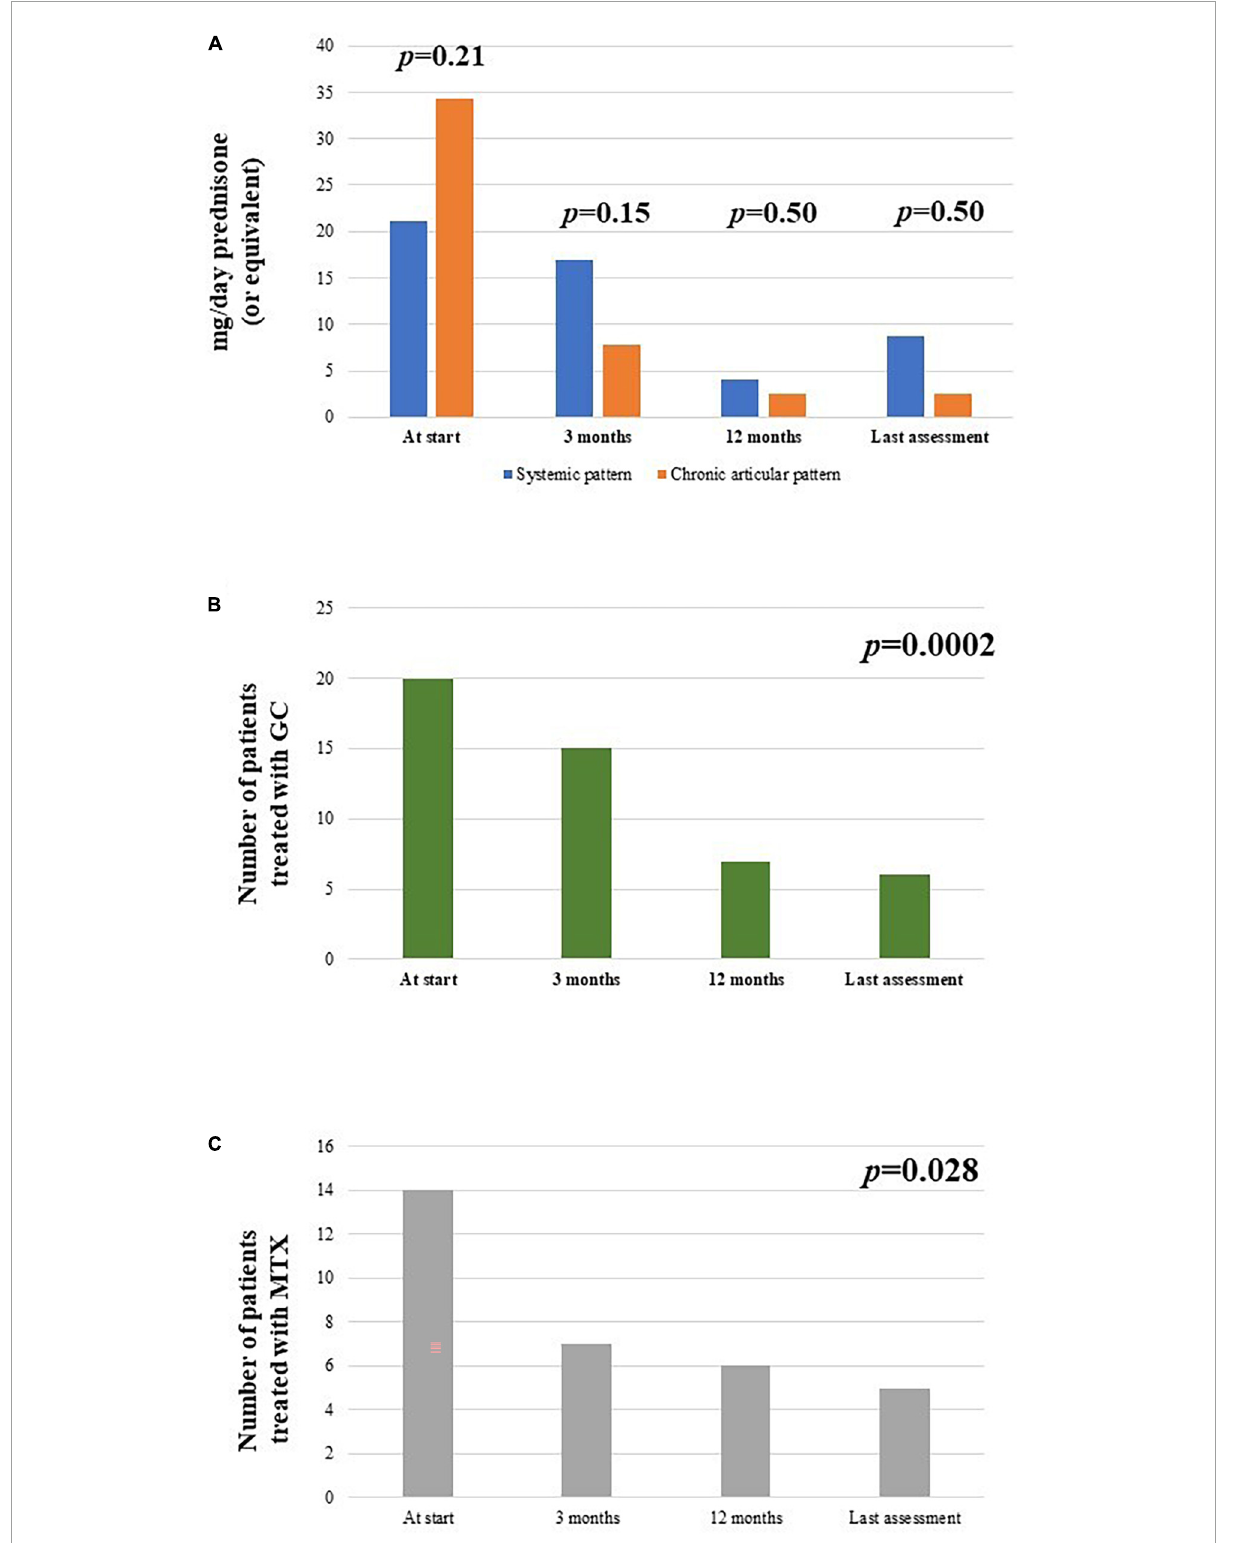
FIGURE8 Description of (A) the median glucocorticoid (prednisone or equivalent) intake as mg/day at the start of canakinumab and at each follow-up visit, distinguishing according to the different disease pattern (systemic versus chronic-articular); (B) the total number of patients administered glucocorticoids (GC) at the different timepoints; (C) the total number of patients administered methotrexate (MTX ) at the different